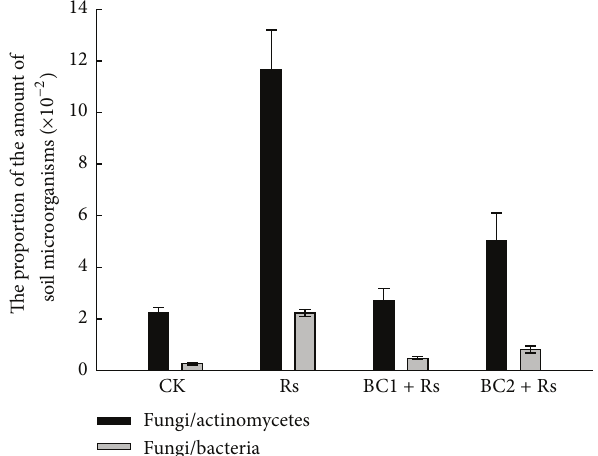
Figure5: Effectsofbiochar amendment and R. solanacearum ontheratioofsoilmicroorganism: fungi/actinomycetes andfungi/bacteria. CK, no biochar and no R. solanacearum inoculation; Rs, R. solanacearum inoculation; BC1 + Rs, peanut biochar amendment and R. solanacearum inoculation; BC2 + Rs, wheat biochar (BC2) amendment and R. solanacearum inoculation.